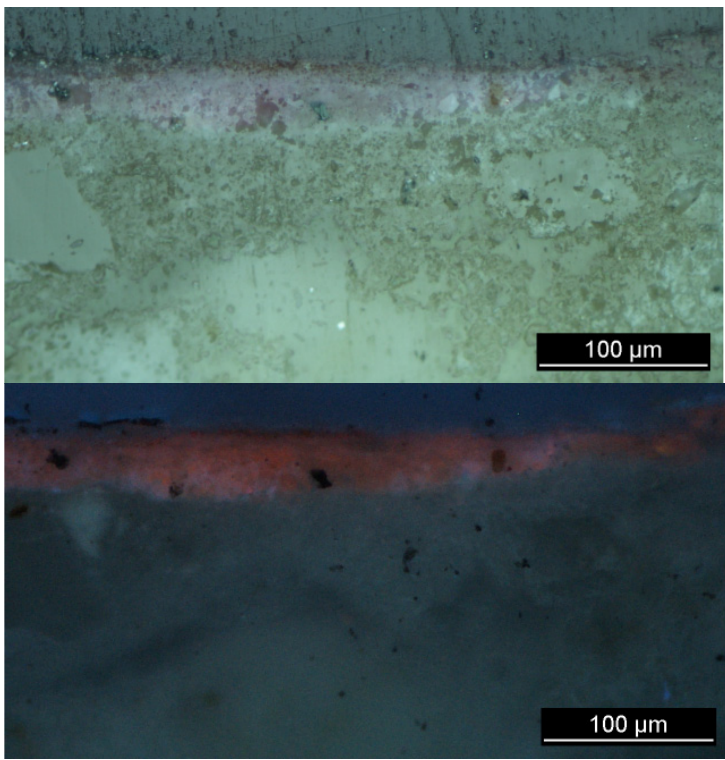
Regarding the pink pigment (sample 1), the large fluorescence background makes the detection of any Raman signal impossible and suggests the presence of an organic dye. The absence of Br, which allows the presence of Tyrian purple to be excluded, as well as the presence of a strong pink-orange UV fluorescence (Figure 5), suggest the use of madder lake [40], an organic dye from the roots of Rubiacee plants.